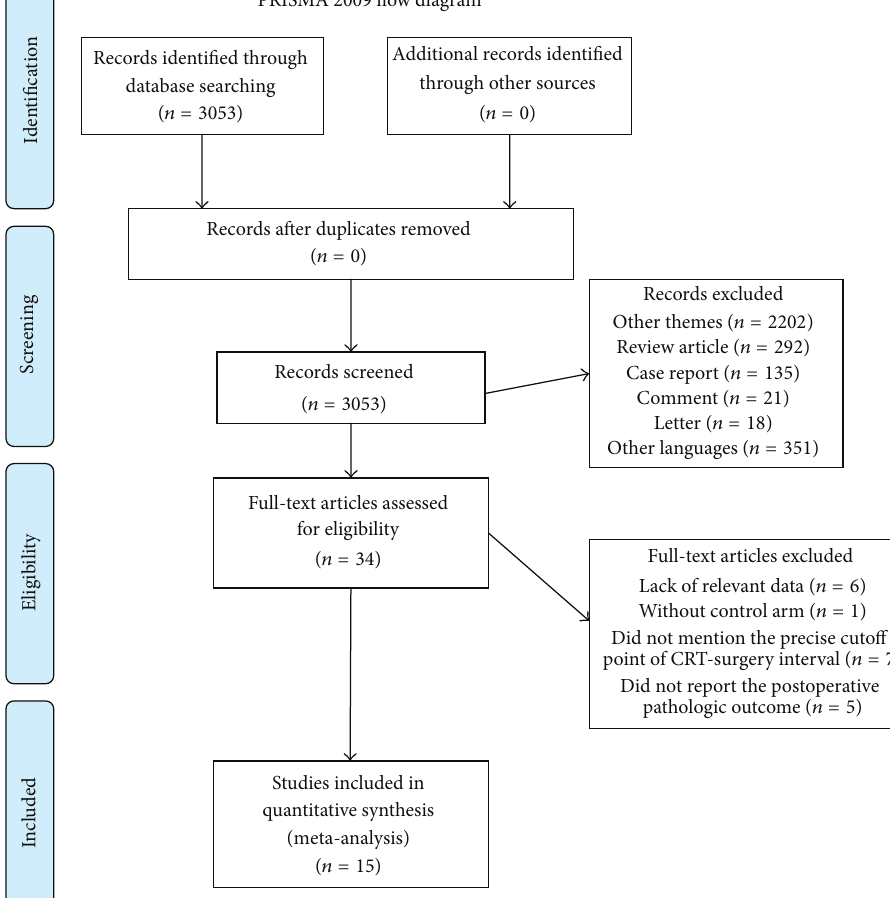
Figure 1: Flowchart of search process.